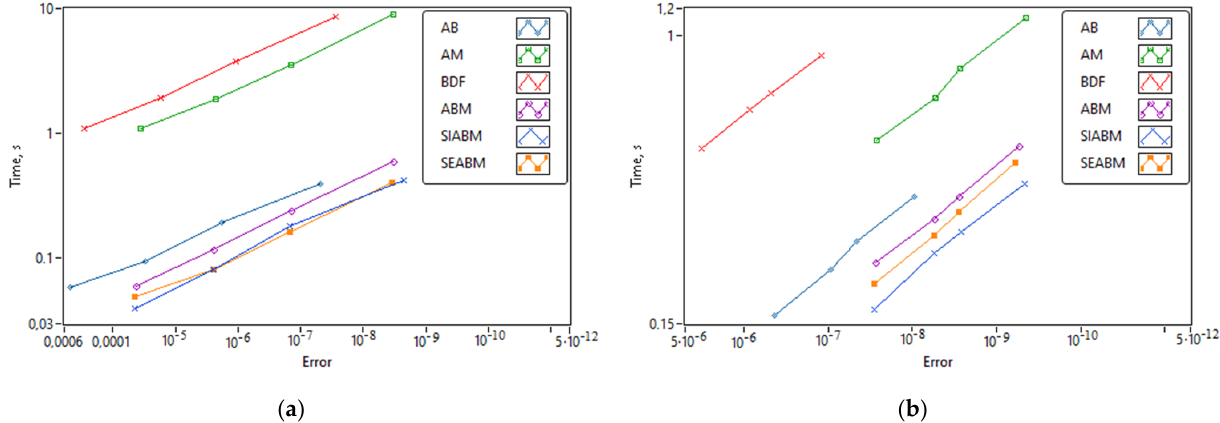
Figure 8. Performance plots for investigated multistep ODE solvers while simulating system (12) with ( a ) fixed integration step; and ( b ) variable integration steps.